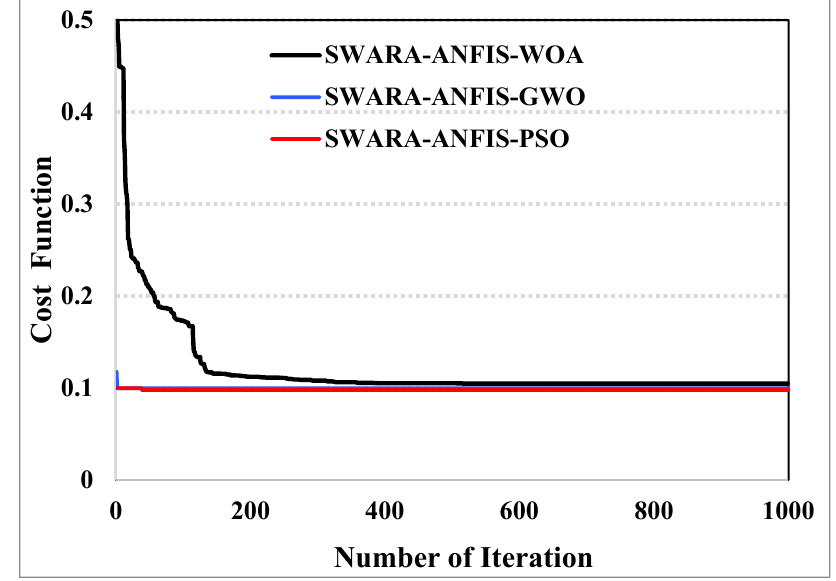
Figure 13. Convergence plot of the SWARA-ANFIS-GWO, SWARA-ANFIS-WOA and SWARA-ANFIS-PSO methods.